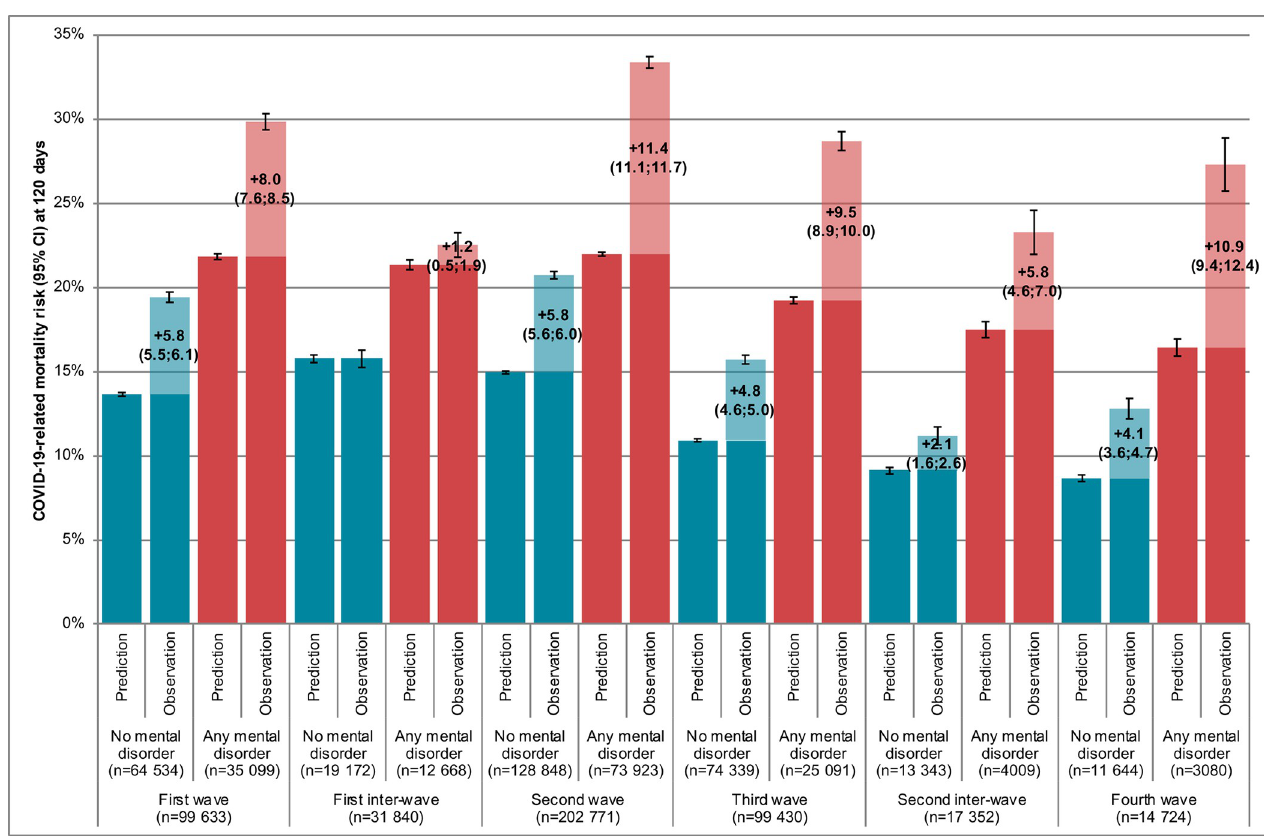
Fig 2. Associations of pandemic periods and preexisting mental disorders with 120-day mortality among inpatients with symptomatic COVID-19 in France ( n = 465,750).